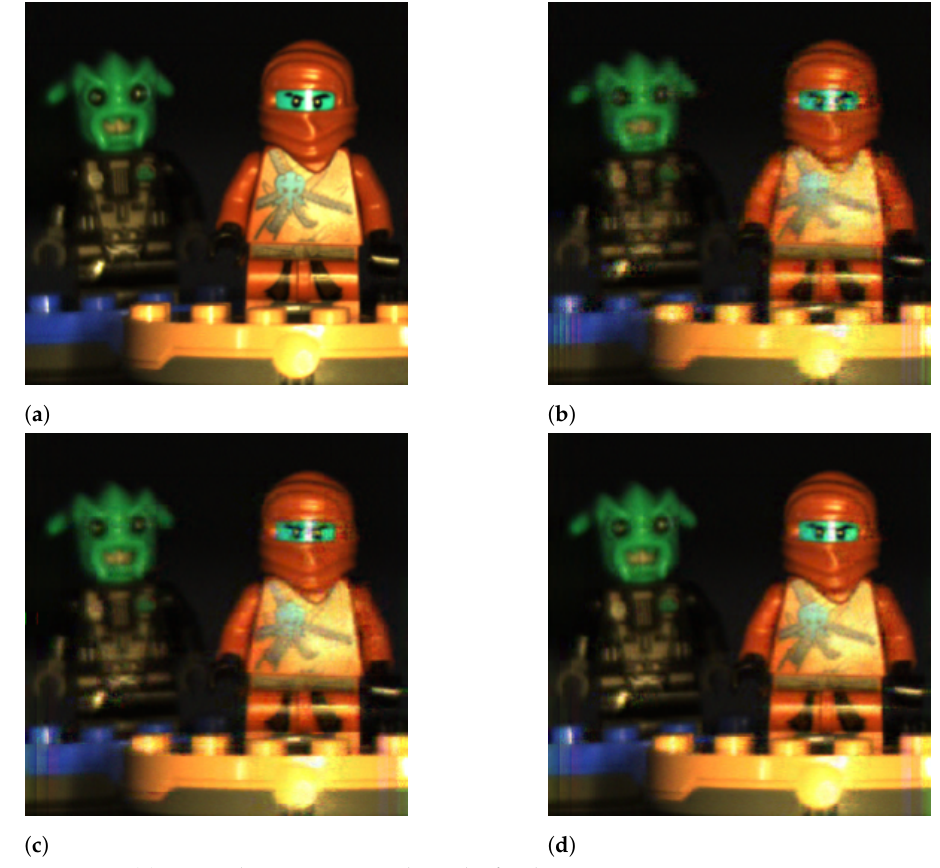
Figure 14. ( a ) Original 256 × 256 × 24 datacube for the “Ninja” image. Reconstructions using 6 shots, the DCT basis, and the LASSO algorithm and considering a block size of: ( b ) 4 × 4 (PSNR = 26.44 dB), ( c ) 8 × 8 (PSNR = 29.11 dB), and ( d ) 16 × 16 (PSNR = 30.57